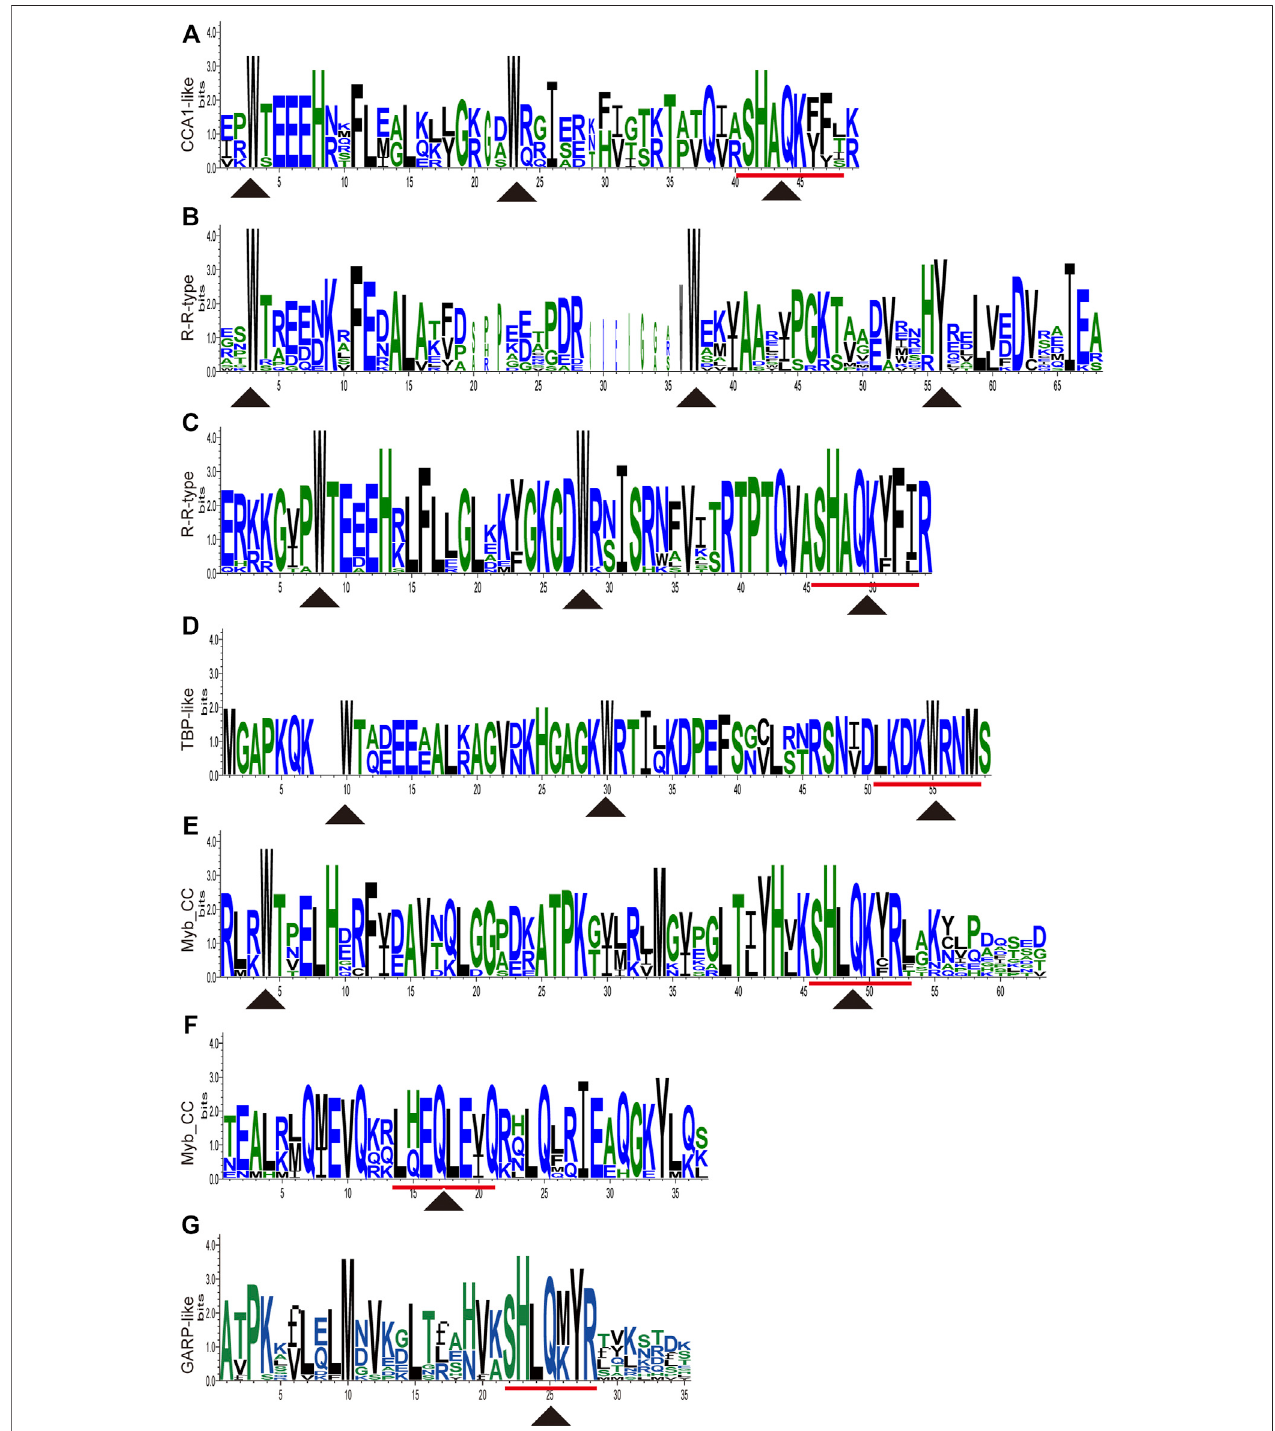
FIGURE 2 | Sequence logos of conserved domains in MYB-related proteins from C. wenyujin . (A) CCA1-like type MYB-related proteins. (B,C) R-R type MYB- related proteins. (D) TBP-like type MYB-related proteins. (E,F) Myb_CC type MYB-related proteins. (G) GARP-like type MYB-related proteins. Y axis indicates the sequence content and its conservation at the corresponding position. Triangles indicate conserved amino acid residues or motifs in the MYB domain. The picture was drawn by TB tools software.